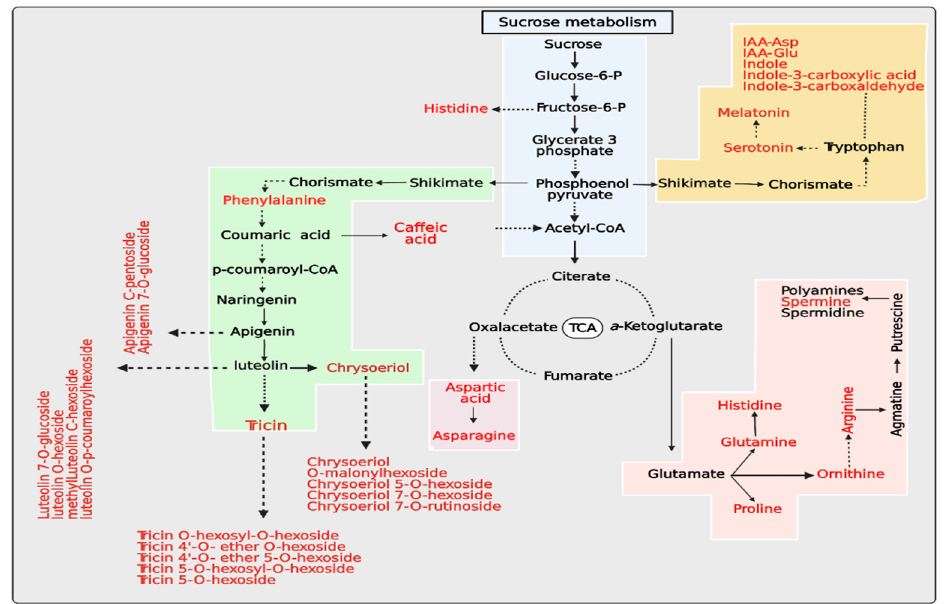
Figure 8. Proposed schematic of top differential metabolites of Yangyou 9 (T) and Zhengsheng 11 (S) exposed to salinity conditions.